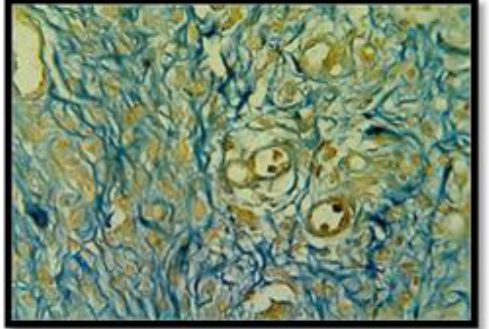
Figure, 3.: Histopathological section in BP- treatment group at 2 nd week post implantation, shows the presence of highly celluar vascular immature granulation tissue with severe hemorrhage(long arrow) numerous congested capillary(short arrow) and moderate mononuclear cells (MNCs) (H&E stain, 100X) .